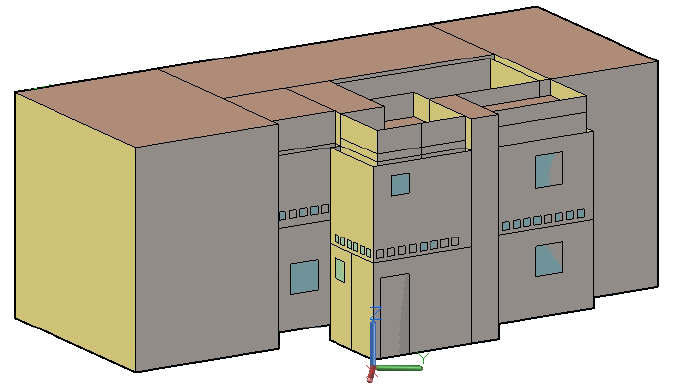
Figure 8. Simulation model of the base case dwelling.